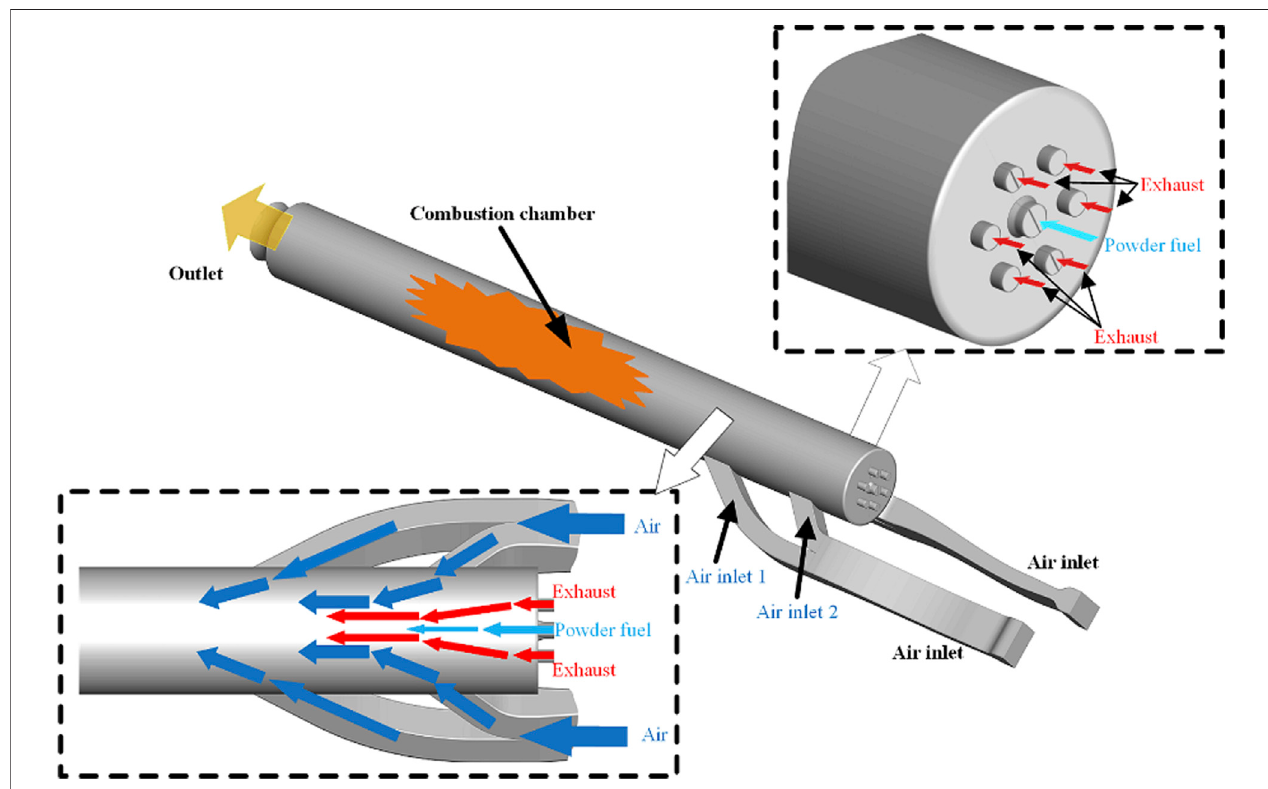
FIGURE 1 | Typical combustion chamber model of the powder-fuel ramjet.